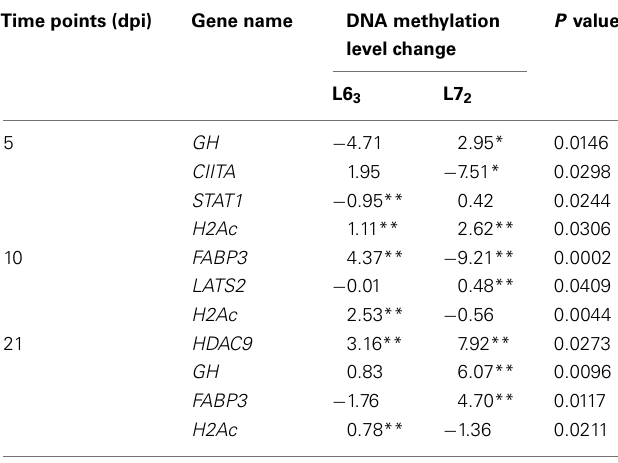
Table 1 | Differential DNA methylation change between L6 3 and L7 2 after MDV